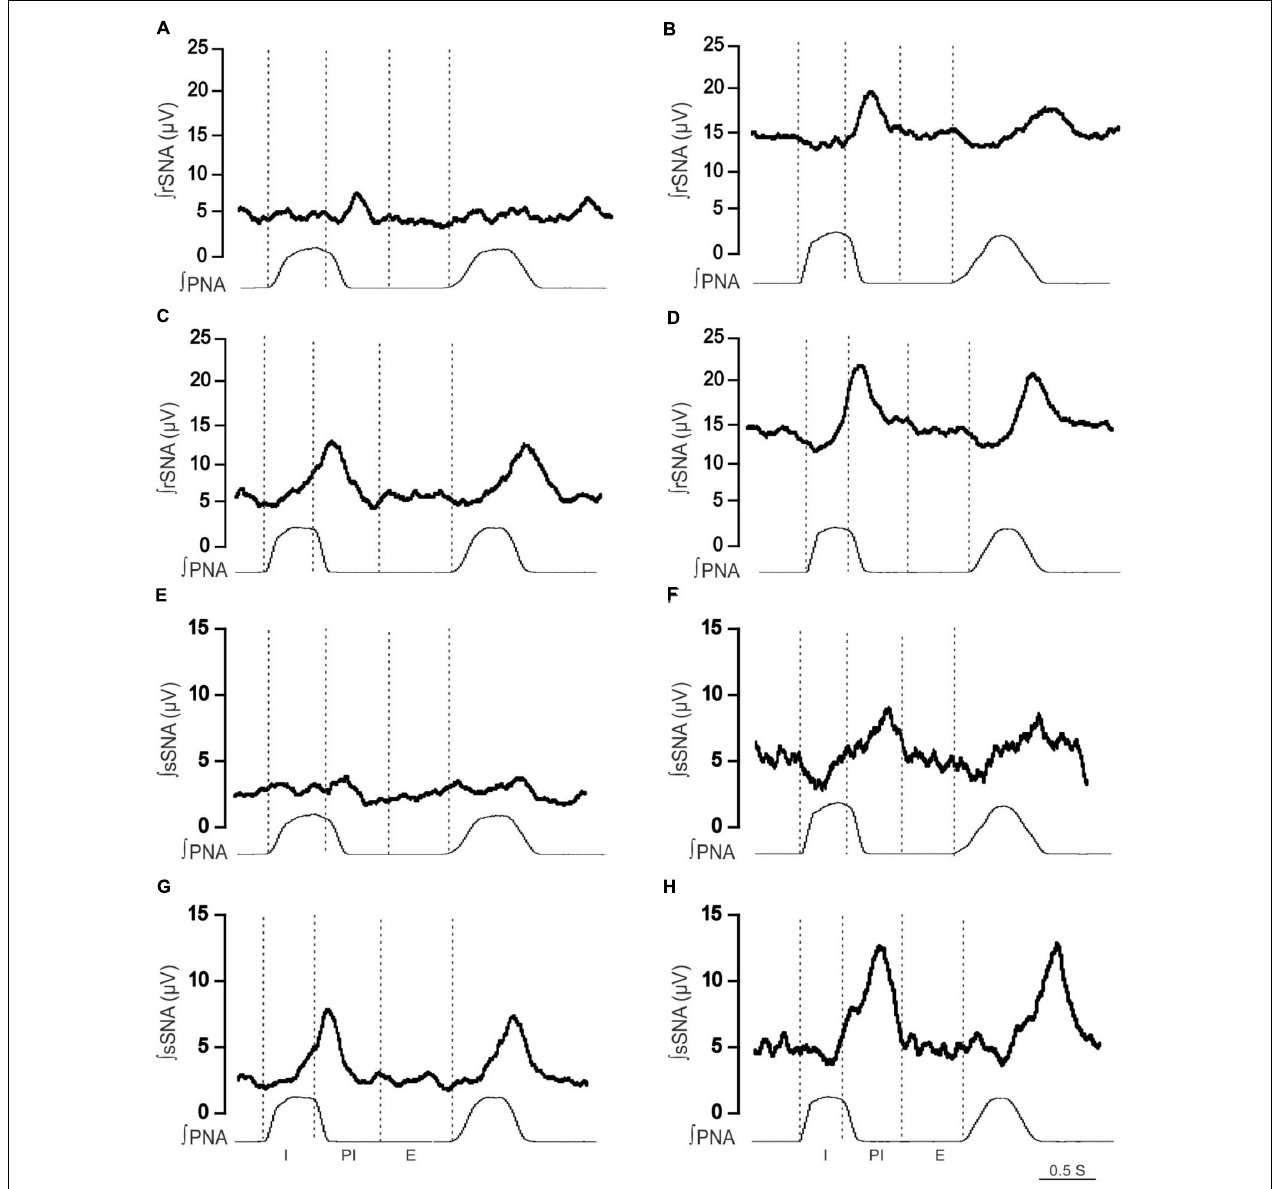
FIGURE 4 | Effect of hypercapnia on respiratory-related sympathetic nerve activity in adult female Lewis and LPK rats. Phrenic-triggered ensemble averages of renal sympathetic ( R rSNA) and splanchnic sympathetic nerve activity ( R sSNA) during different phases of the phrenic cycle (I, inspiration; PI, postinspiration; E, expiration) under control (A,B,E,F) and hypercapnic conditions (C,D,G,H) in a Lewis rat (A,C,E,G) and LPK rat (B,D,F,H)